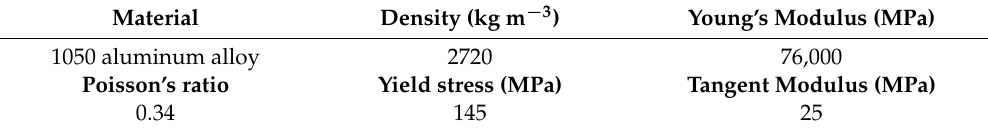
Figure 3. Finite element model based on flexible rolling equipment. Table 2. Material properties of 1050 aluminum alloy in the numerical